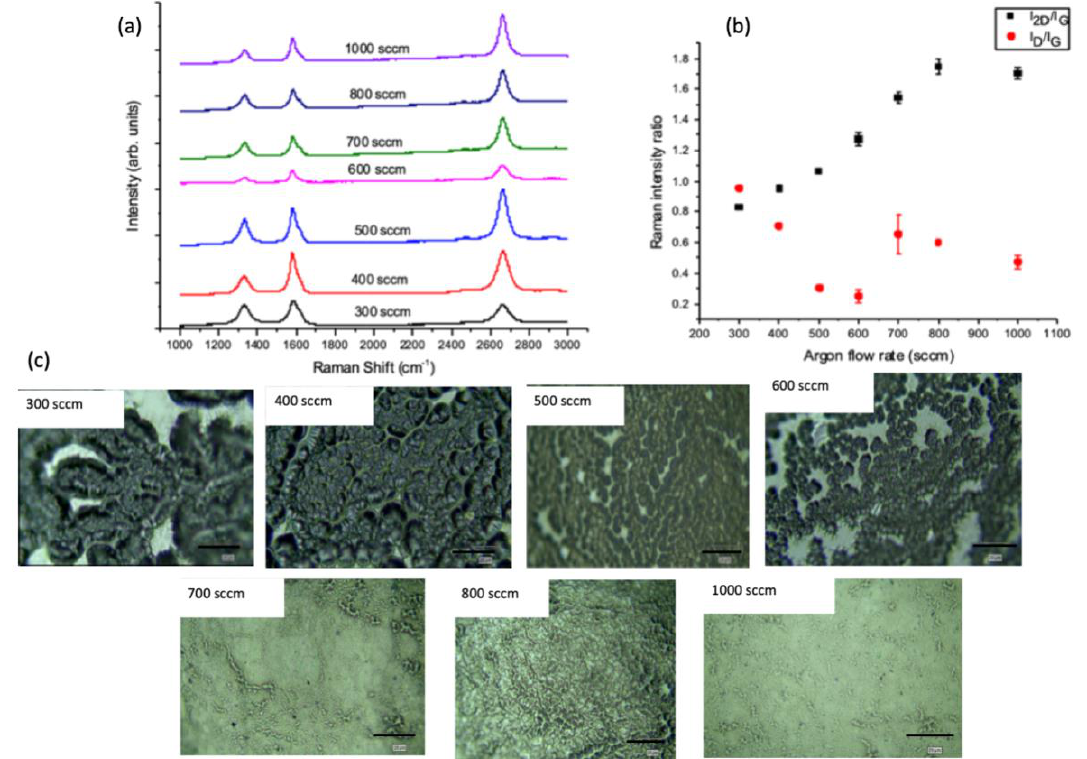
Figure 6. Summary of data of APCVD graphene on liquid In at high Ar flow rates (sccm), grown for 15 min ( a ) Raman spectra of APCVD graphene using high Ar flow rates (sccm) ( b ) optical images of the grown graphene film (scale bar 20 µ m) and ( c ) Average Raman intensity ratio I 2D /I G and I D /I G values vs. the Ar flow rate based on maps data (error bars are smaller than some data points). (Raman laser energy: 633 nm).